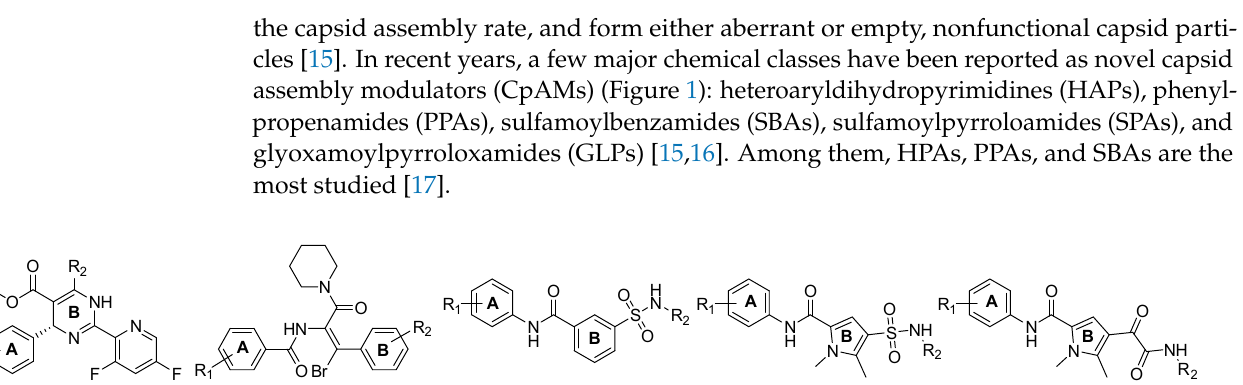
Figure 1. Major chemical classes of CpAMs. Common ring features are labelled as A and B .